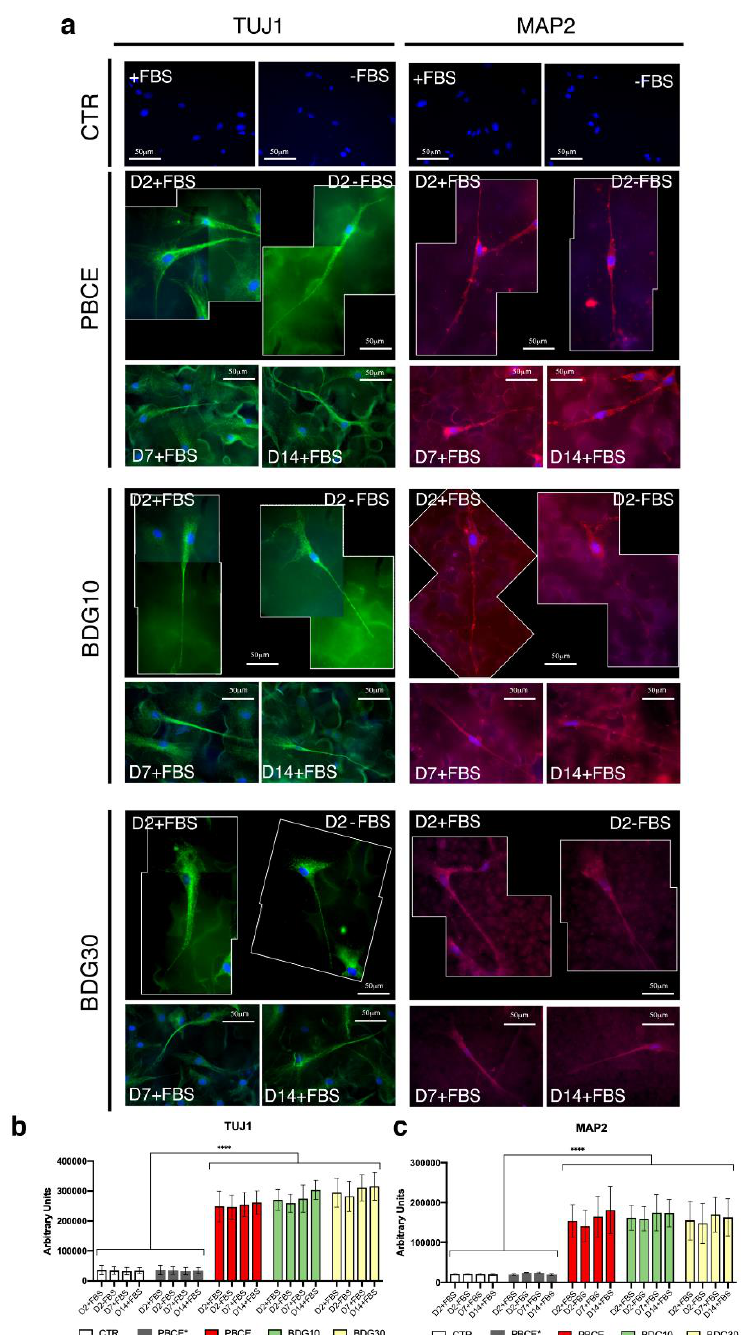
Figure 7. Expression of TUJ1 and MAP2 in hBM-MSCs grown on PBCE, BDG10 and BDG30. ( a ) Representative fluorescence images of hBM-MSC nuclei (DAPI, blue), TUJ1 (human anti-TJU1 antibody, green), and MAP2 (human anti-MAP2 antibody, red), revealed the absence of TUJ1 and MAP2 in cells on CTR cultures, both in FBS presence (+) and absence (-). TUJ1 expression in stem cells on PBCE, on BDG10 and on BDG30 at different time points (D2-D14 in the presence (+) FBS and at D2 and in the absence (-) of FBS). MAP2 expression in stem cells on PBCE, on BDG10 and on BDG30 at different time points [D2-D14 in the presence (+) FBS and at D2 in the absence (-) of FBS]. Scale bar 50